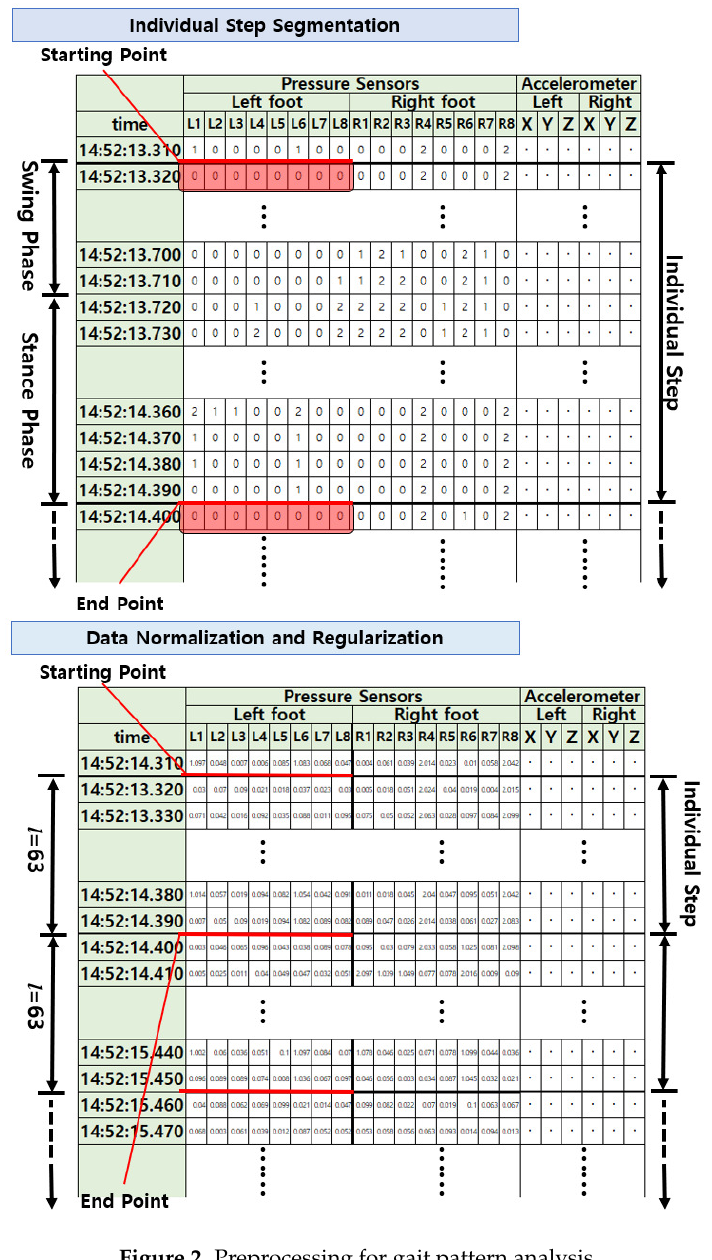
Figure 2. Preprocessing for gait pattern